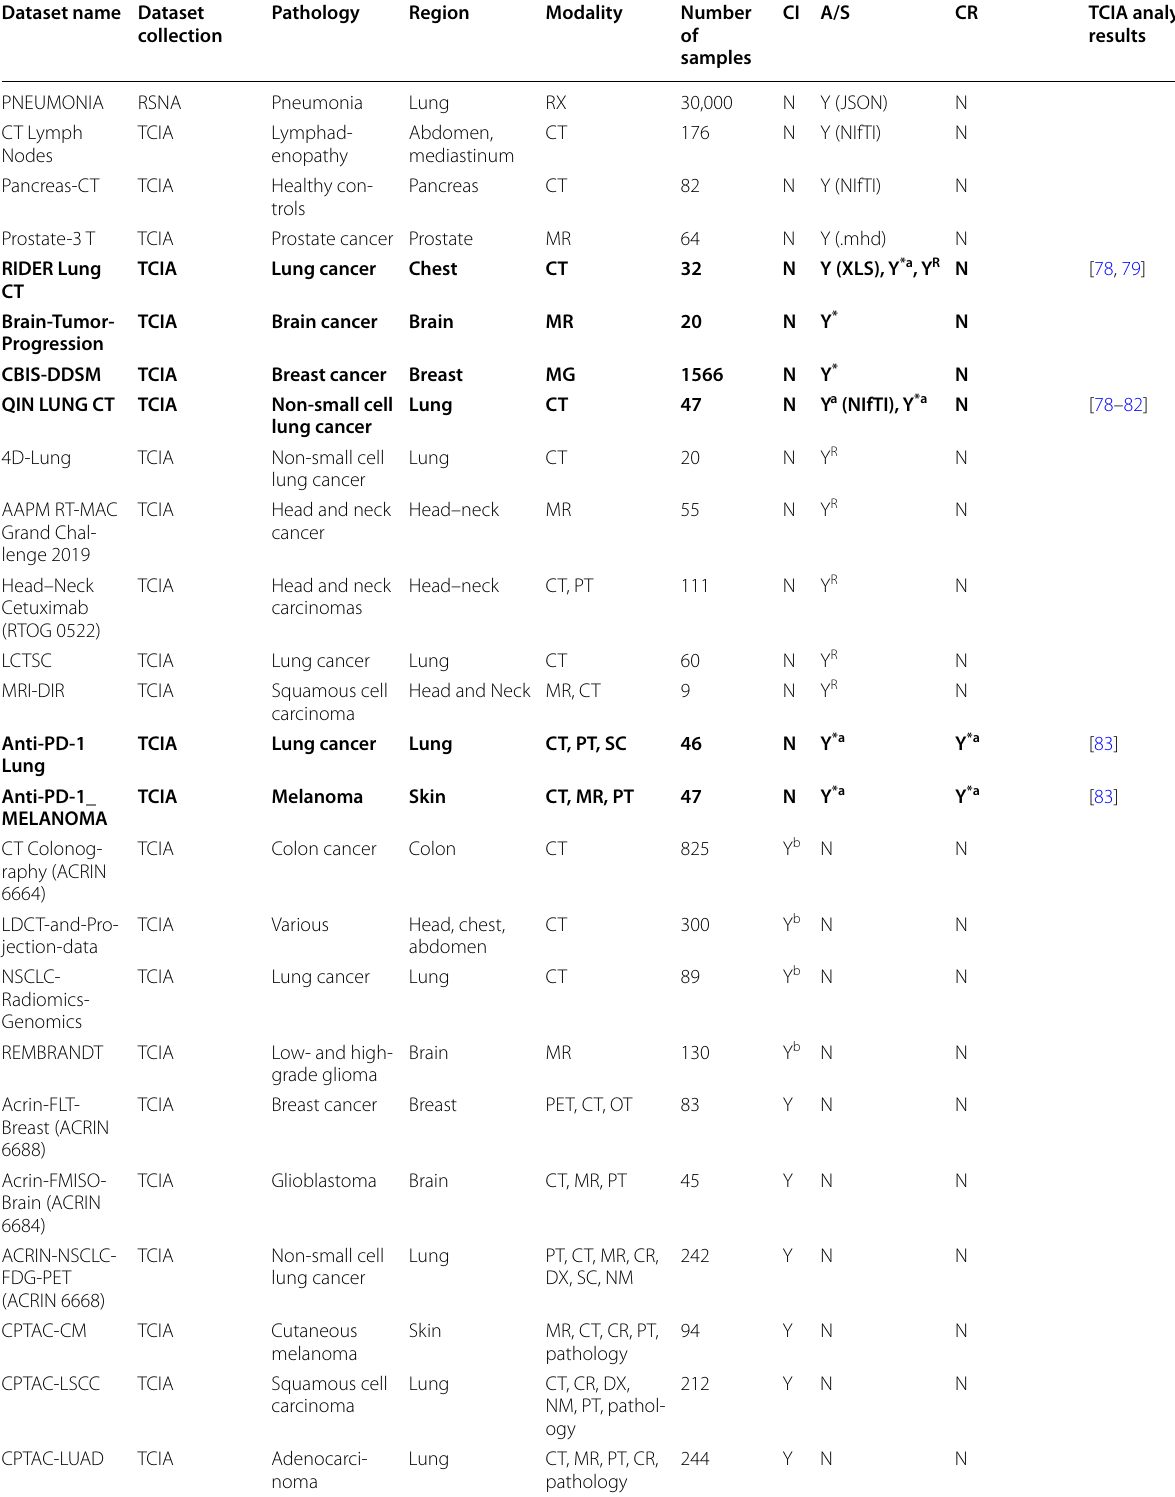
83) providing additional information other than DICOM images =